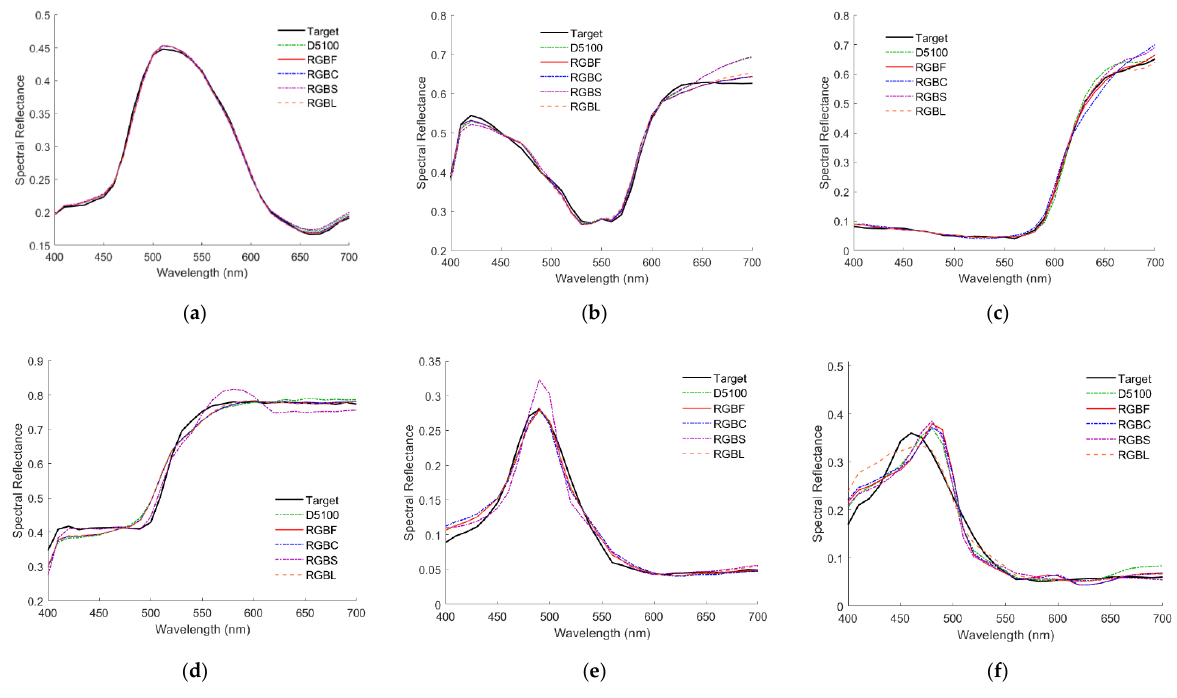
camera. Figure 10a–f are the same as Figure 9a–f, respectively, except that spectra were recovered using the wPCA method.